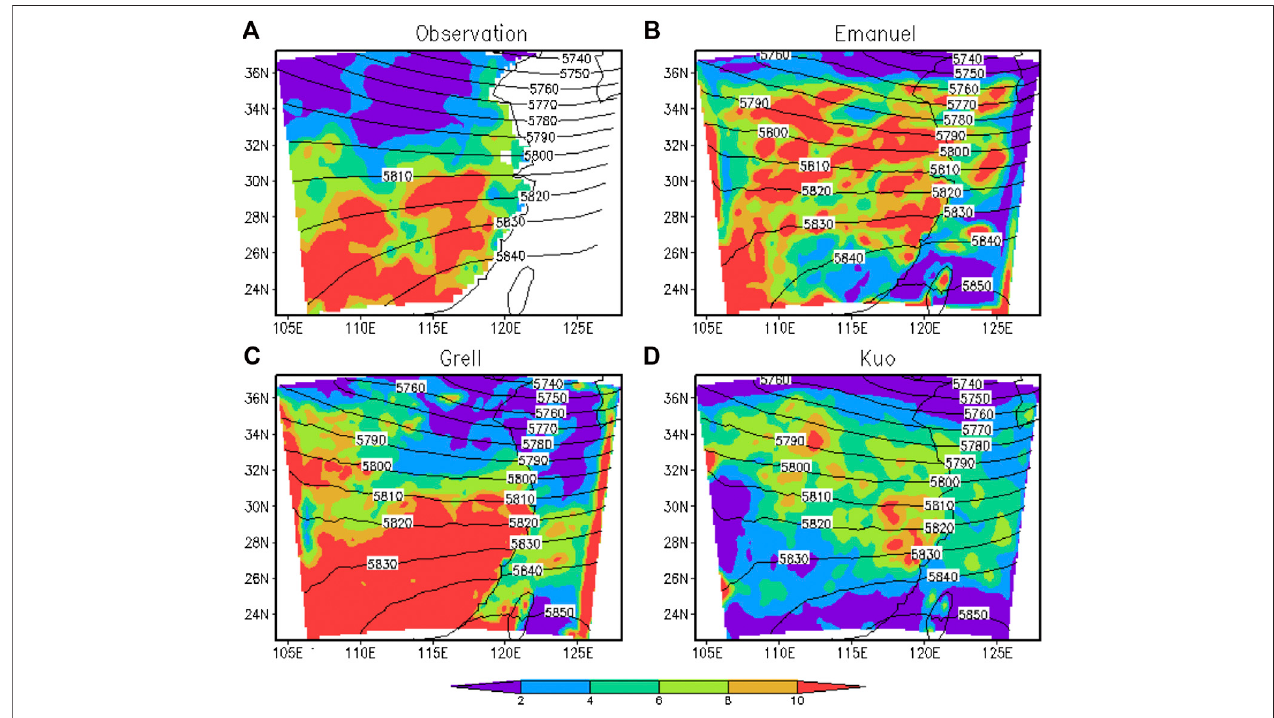
FIGURE 8 | Spatial distributions of precipitation (unit: mm/day) and 500- hPa geopotential height (unit: gpm) during the Meiyu season of 1974 from observations and simulations by the Emanuel, Grell, and Kuo schemes.